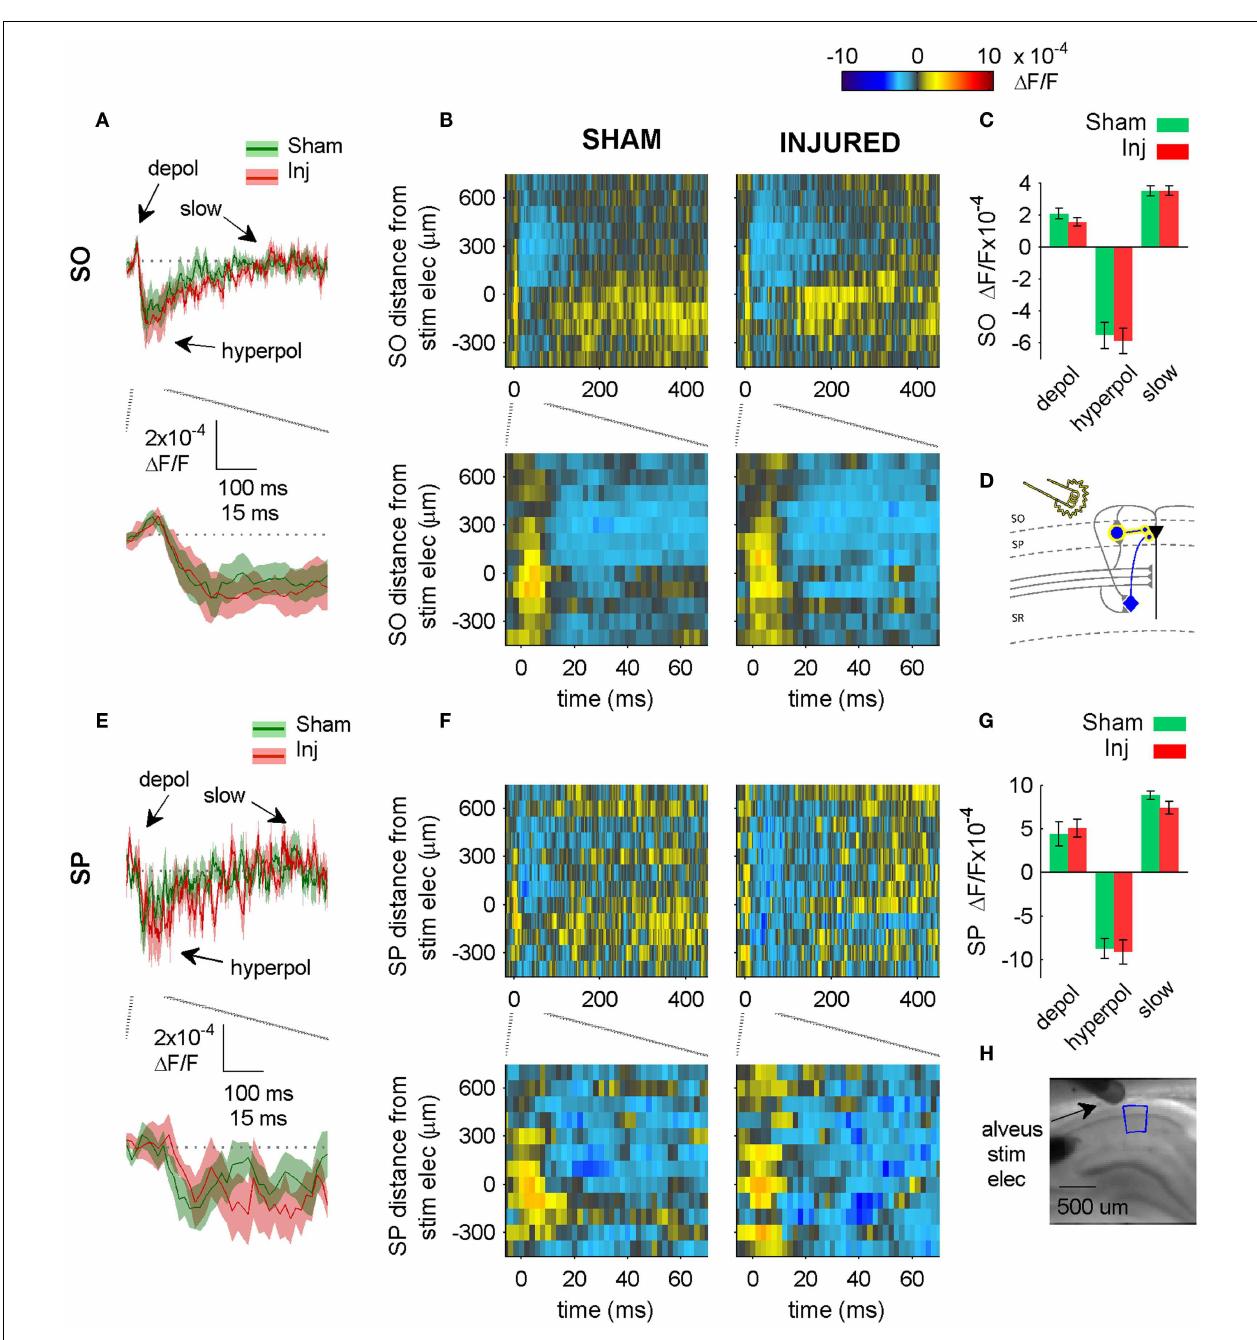
observed. (D) Schematic showing direct activation (yellow highlight) of interneuron synapses in SP and SO. Schaffer collaterals are shaded gray to indicate non-activation by alveus stimulation. Pyramidal neuron axons are shaded gray to emphasize that glutamatergic transmission has been blocked. Same legend as in Figure 1A . (H) Photomicrograph from a representative slice showing typical location of stimulating electrode and region used for analysis of alveus-stimulated responses. Positive distances from electrode are toward subiculum, negative distances are toward CA3. Stimulus: 100 µ A. Sham n = 9, injured n = 8. Abbreviations: SO, stratum oriens; SP, stratum pyramidale; Inj, Injured; depol, depolarization; hyperpol, hyperpolarization; stim elec, stimulating